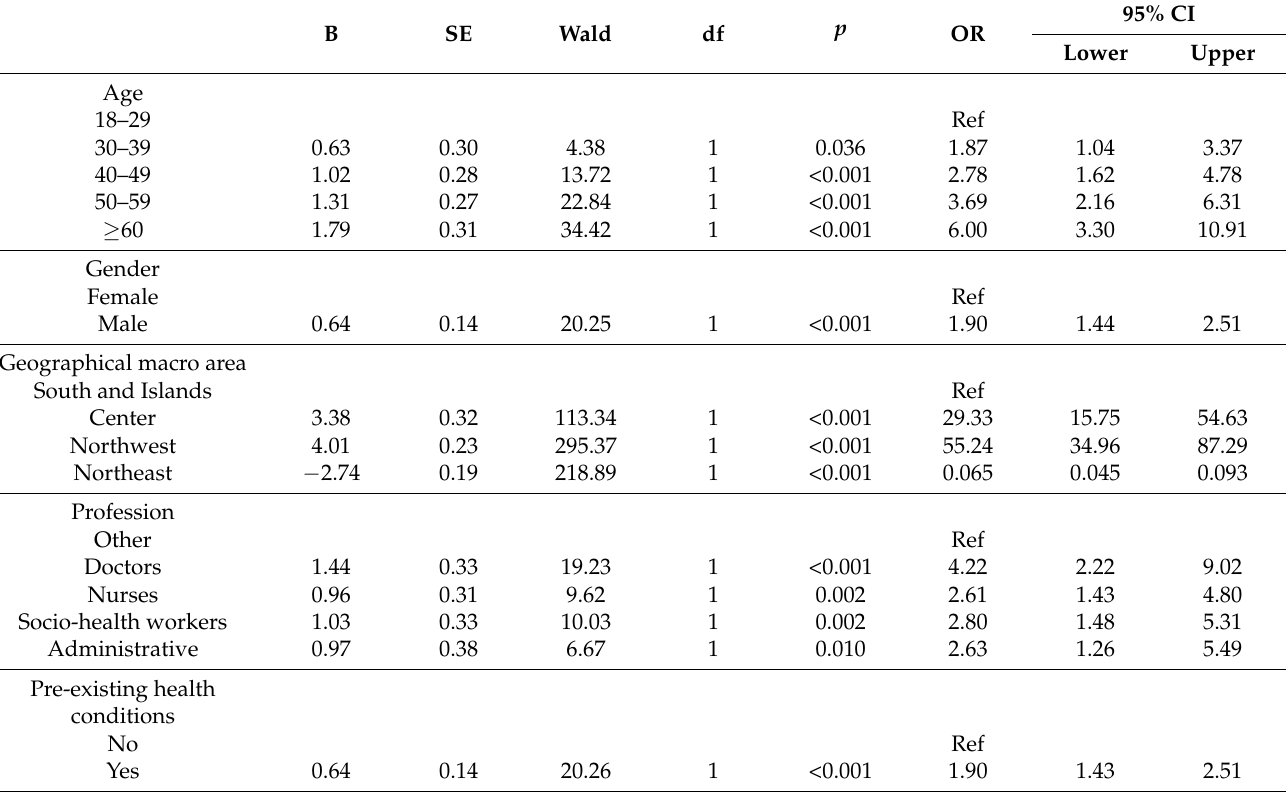
Table 5. Logistic regression predicting the likelihood of a severe disease outcome based on age, gender, geographical macro area and